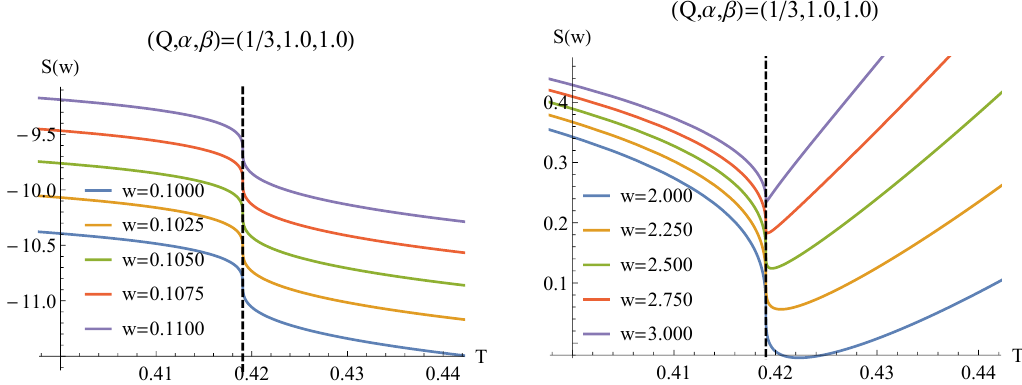
Figure 5 . The relationship between the temperature and the HEE for small (left plot) and large widths (right plot) at the critical case with second-order phase transition. The red dashed horizontal line represents the critical temperature T c = 0 . 4191 of the second-order phase